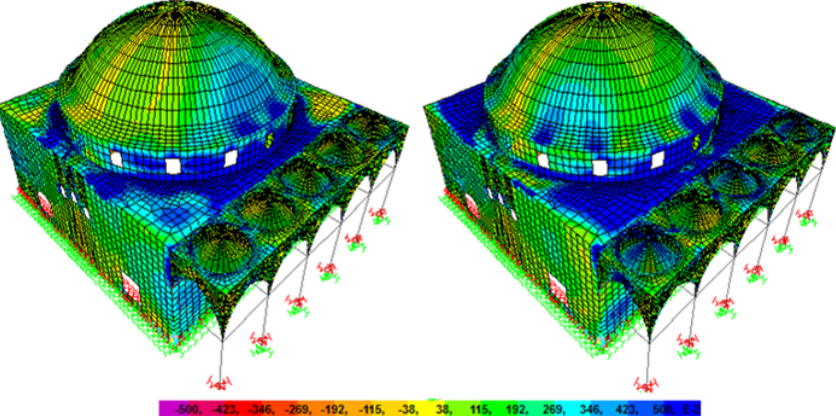
Figure 8. Maximum shear stresses contour diagram for the outer and inner surfaces of the mosque with 16 window openings under dead load and earthquake load (G +